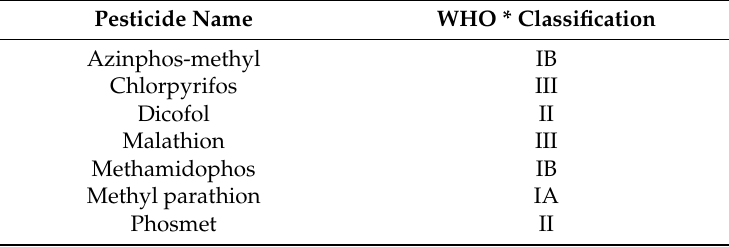
Table 3. Organophosphate pesticides commonly used by the study population. World Health Organization classification: Class IA, extremely hazardous; Class IB, highly hazardous; Class II, toxic; Class III, moderately toxic. Pesticide Name WHO * Classification Azinphos-methyl IB Chlorpyrifos III Dicofol II Malathion III Methamidophos IB Methyl parathion IA Phosmet II